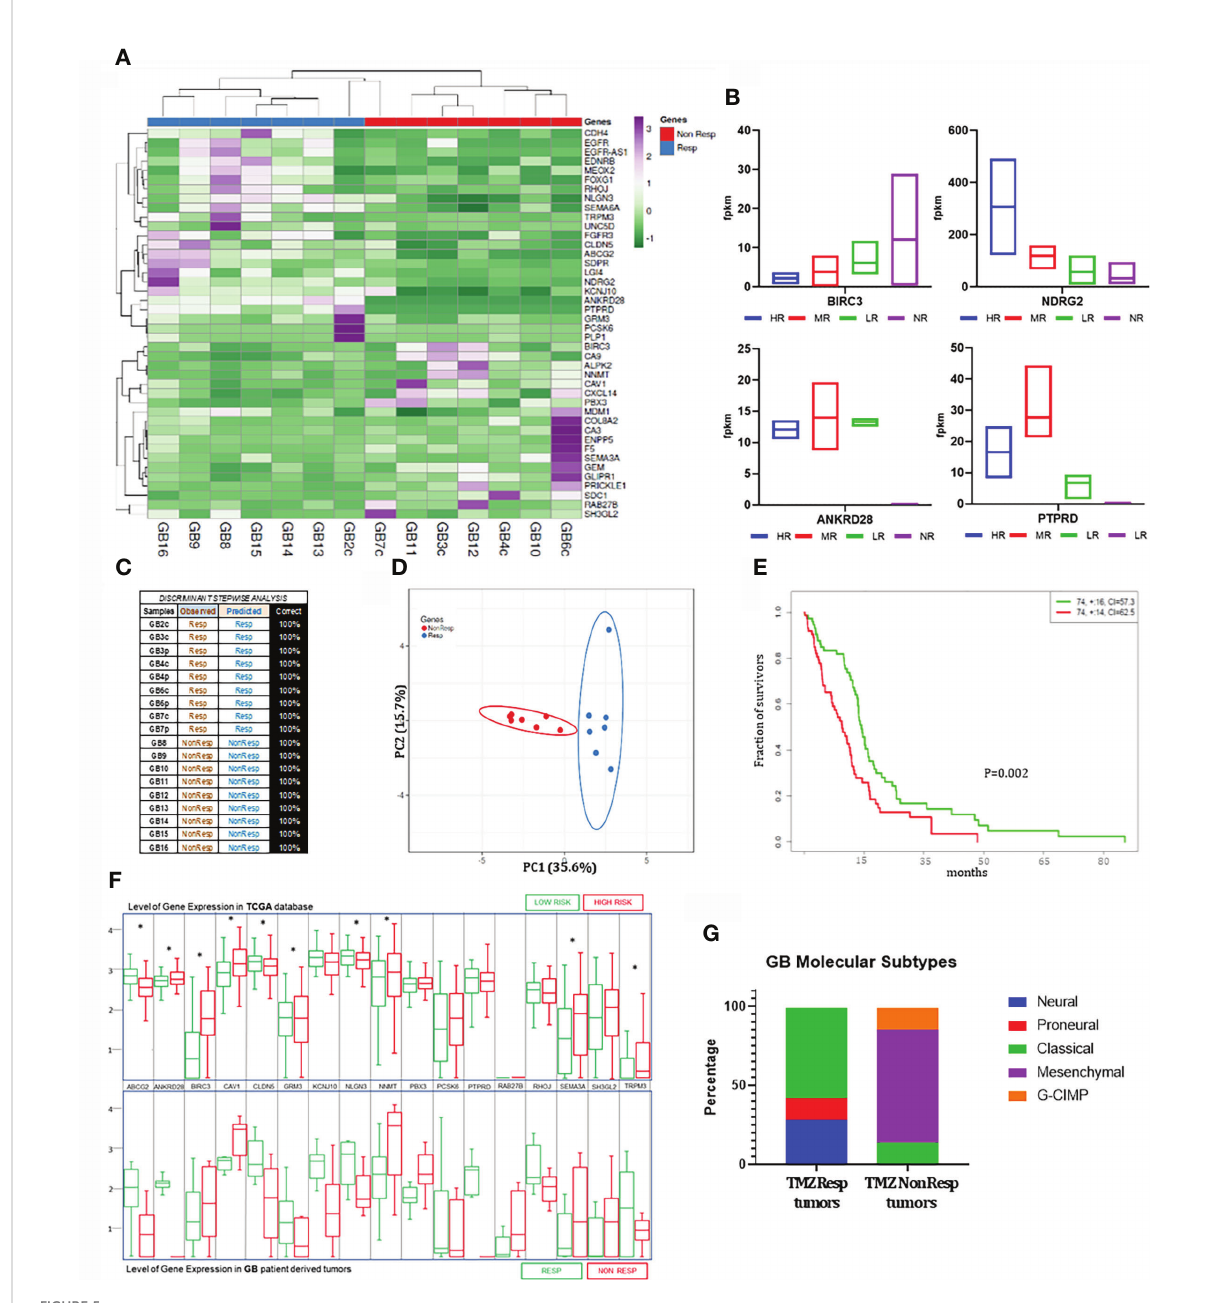
FIGURE 5 Gene expression pro fi ling of GB-EXPs. (A) Heatmap of 42 genes from RNAseq data differentially expressed (DE) between Resp (n=7) and Non- Resp (n=7 (tumor peripheral portions were excluded). (B) Expression levels of 4 genes subdivided in HR (n=2), MR (n=4), LR (n=3) and NR (n=9) groups (peripheral portions were included). (C) Stepwise discriminant analysis identi fi es a combination of 17 DE genes that discriminates the Resp (n=9) and Non-Resp (n=9) cases with 100% accuracy (peripheral portions were included). (D) PCA showing RNAseq data of 17 DE genes in 7 Resp and 7 Non-Resp (tumor peripheral portions were excluded. (E) The 17 gene panel Kaplan-Meier plot that identi fi es a TCGA Low-Risk and High-Risk survival group. Concordance Index = 64.34, Log − Rank Equal Curves p=0.001853, R^2 = 0.192/0.998 Risk Groups Hazard Ratio = 1.79 (conf. int. 1.23 ~ 2.6), p=0.002172. (F) Expression levels of the 17 discriminant genes in TCGA database (in the top) and in GB tumors (9 Resp and 9 Non-Resp. in the bottom). (G) Molecular subtypes of GB samples in Resp (n=7) and Non-Resp (n=7) groups. Asterisks indicate level of statistical signi fi